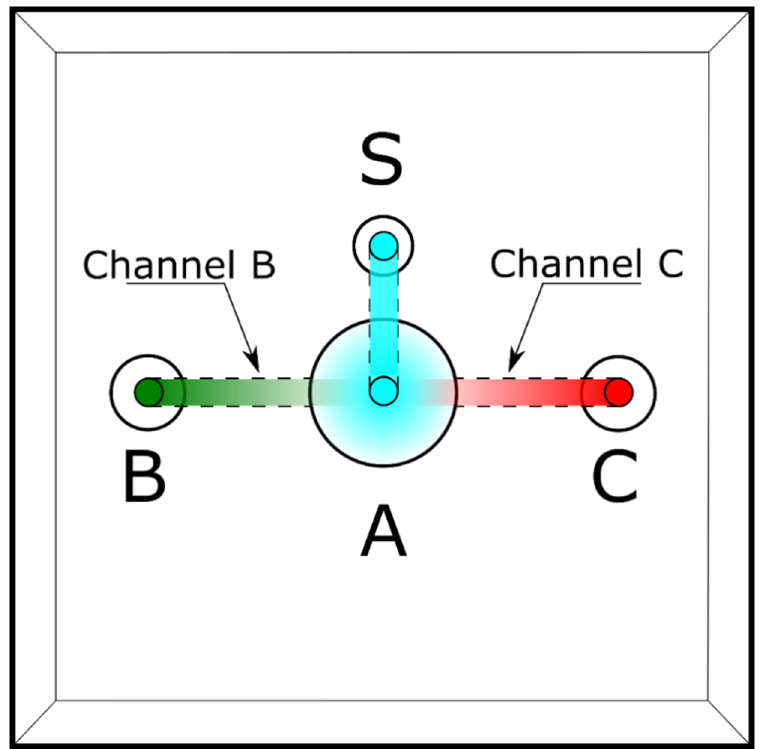
Figure 1. A schematic representation of the sperm selection chamber used. A: the main chamber where sperm are activated. S: The well where the sperm are added. B and C: the wells used for the chemoattractant (FRF) and control solution (water). More details, a step-by-step protocol, and the 3D project are available in Supplementary Materials.